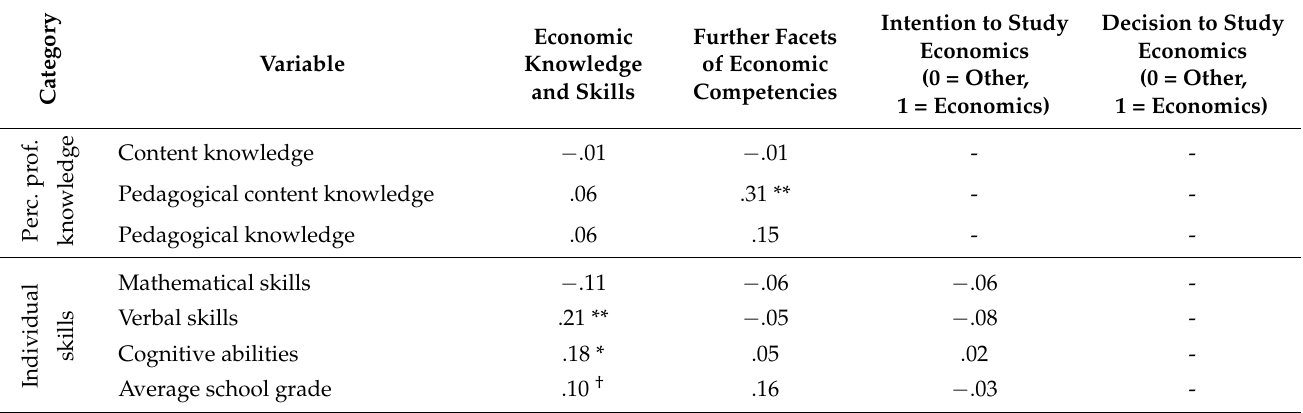
Figure 3. Path model for the influence of economic competencies and perceived professional knowledge on the aspiration and choice of an economics study course. Model fit indices: χ 2 = 22.2, df = 15; RMSEA = 0.034, CFI = 0.97; TLI = 0.92; SRMR = 0.023. Table 13. Direct effects of the path